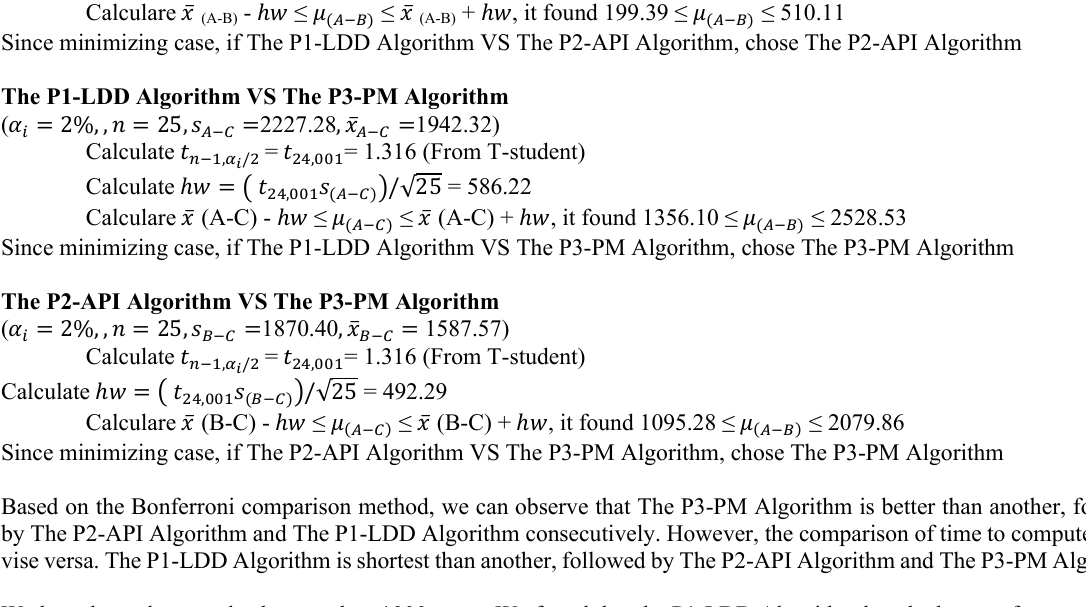
The P1-LDD Algorithm VS The P2-API Algorithm